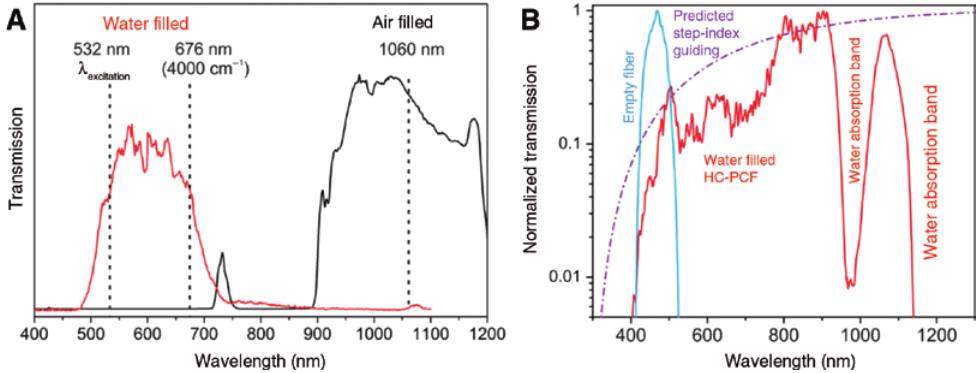
Figure 8: Transmission spectra of two different hollow core fibers for FERS of